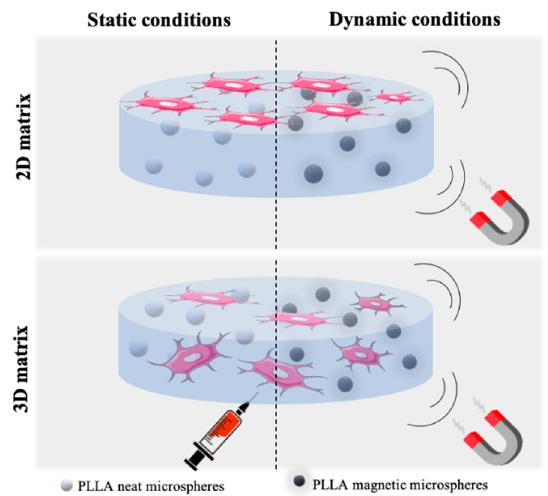
Figure 1. Schematic representation of cell culture conditions.